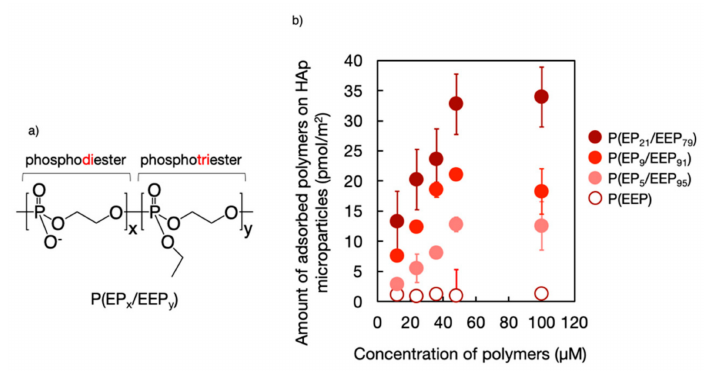
Figure 3. ( a ) Chemical structure of polyphosphoester copolymers (P(EP x / EEP y )) and ( b ) the e ff ect of